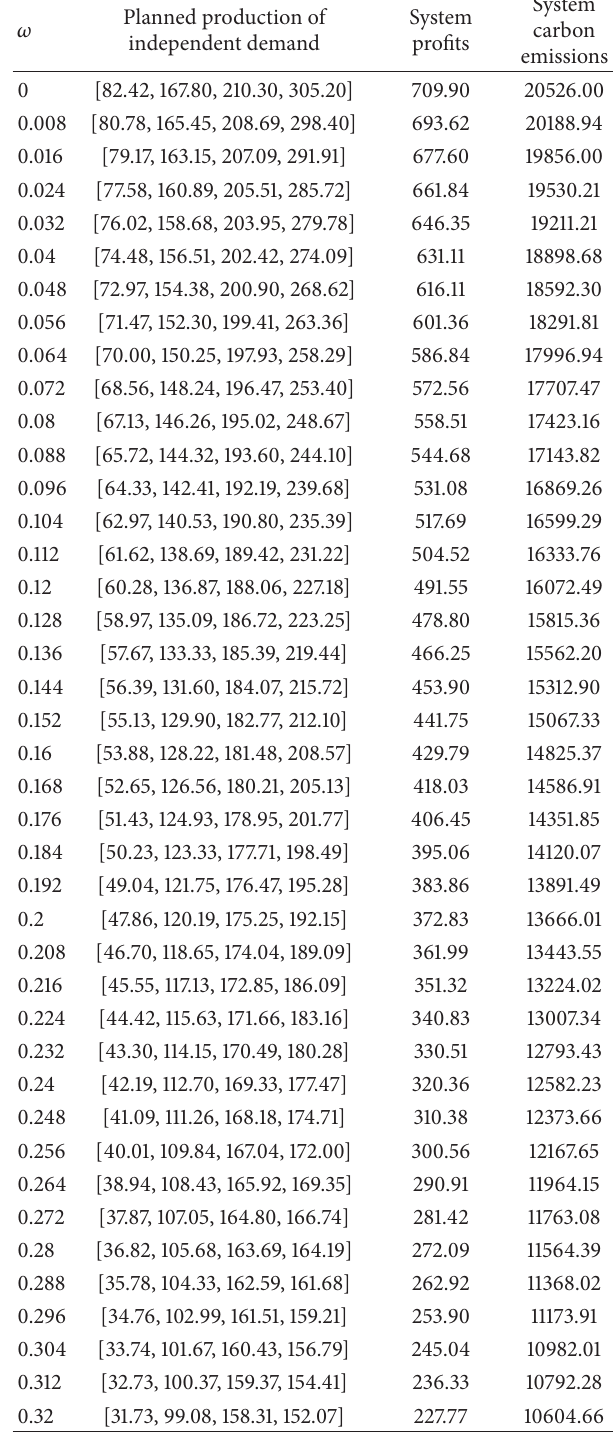
Table 3: Sensitivity analysis of production planning of independent demand and the supply chain profit to carbon tax 𝜔 of unit carbon